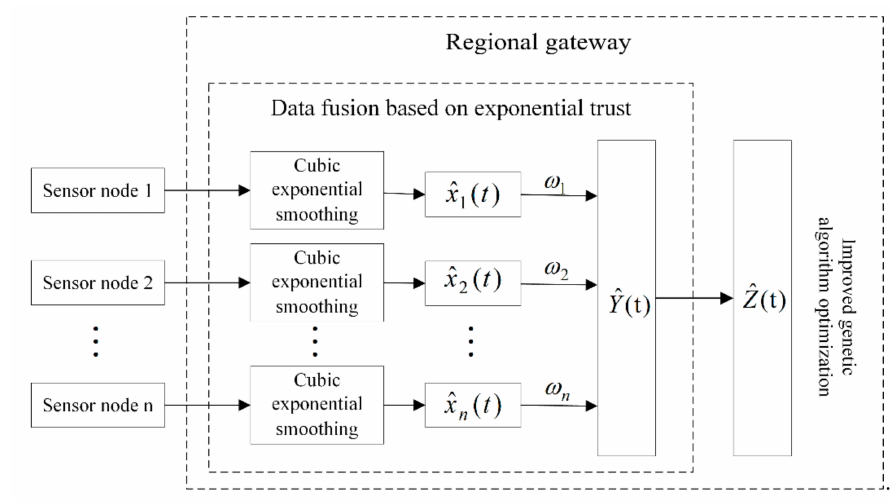
Figure 1. Greenhouse WSNs system data fusion structure model